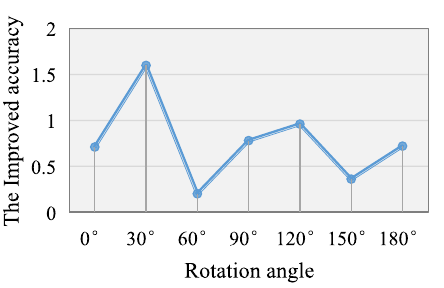
Fig. 7 The object detection result of the proposed method, over the VOC dataset